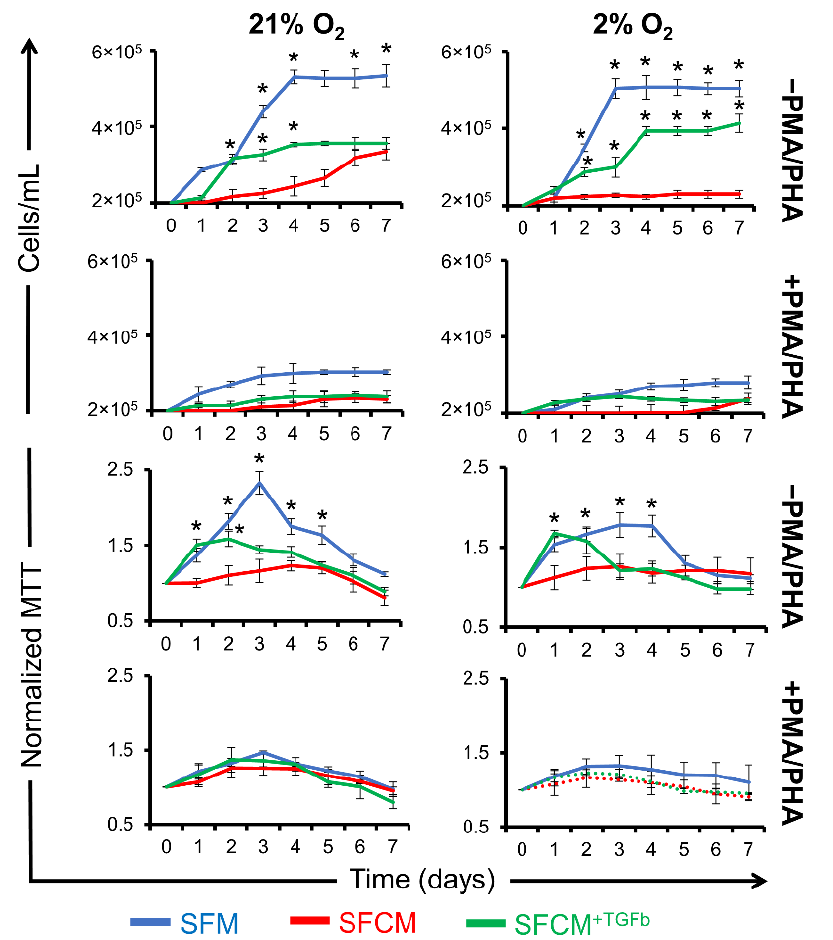
Figure 6. TGFb failed to suppress Jurkat cell proliferation. Growth curves plotted from cell numbers (cells/mL) and optical density (O.D.) values for MTT assays for polarised Jurkat T cells cultured in SFM, SFCM, SFM +Ligand , SFM +Ligand/antiLigand AB , and SFCM +antiLigand AB in air (21% O 2 ) and physoxia (2% O 2 ) environments over a 7 day period. Growth curves were obtained by haemocytometer-based cell counting, and the results were confirmed through MTT assays. Data expressed as mean ± SD; each result represents a replicate of 3 independent experiments ( n = 3). One-way ANOVA was conducted with Tukey’s test to determine pairwise significant difference. * p < 0.001.